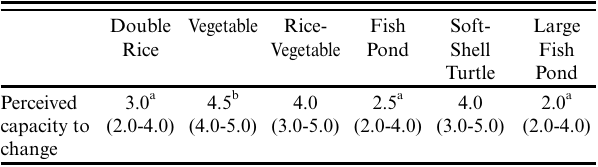
Table 6 . Median values of perceived capacity to change of agricultural systems by the interviewed farmers in the Red River Delta (interquartile ranges in parentheses). The values in the table represent a “1-5 Likert scale” standing for very little (1) to very much (5) ability. Significant difference of perceived capacity to change between farming systems ( χ ²(5) = 20.06, p = 0.001; Kruskal-Wallis test). The median values with different superscripts are significantly different (p < 0.05, Dunn’s